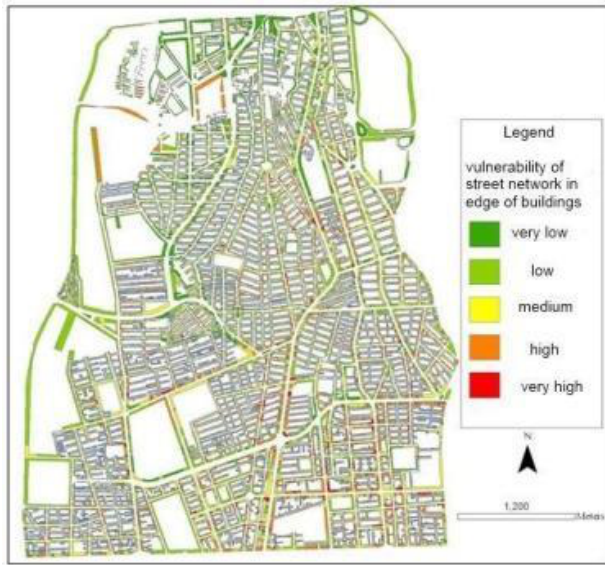
Figure 3: determining the vulnerability degree of street networks against the earthquake in zone #6 of Tehran